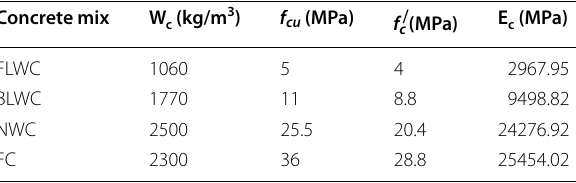
Table 2 Elasticity modulus of all concrete mixtures Concrete mix